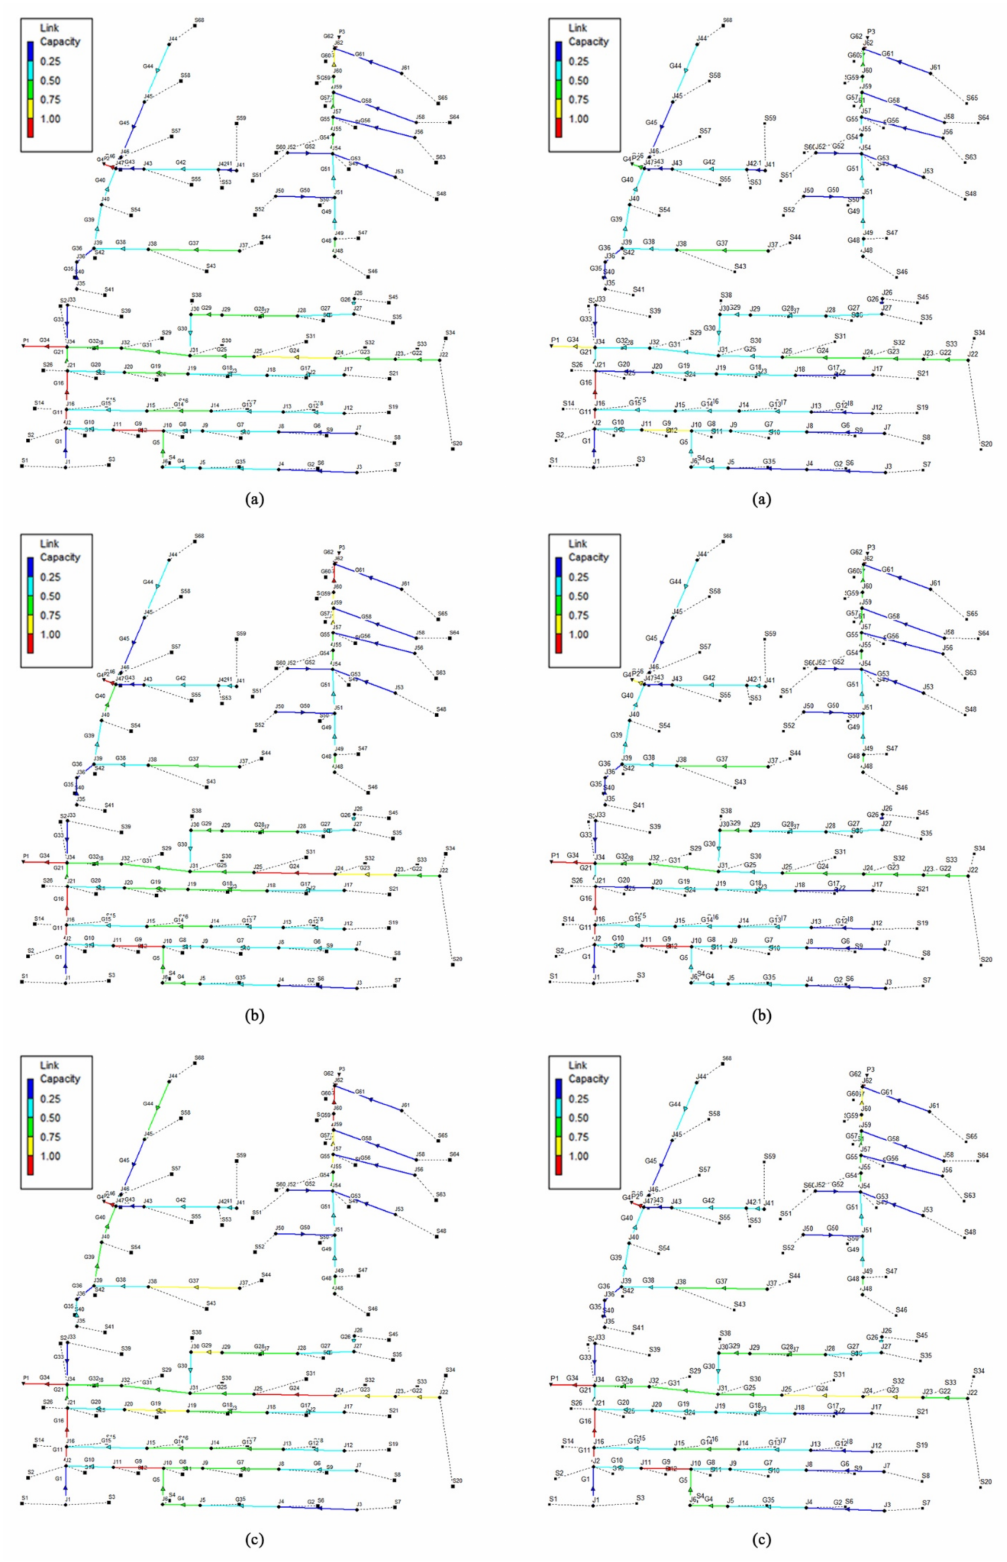
Figure 8. Flood simulation of each link for Scenario 1 (left) and 2 (right) under storm conditions with 5-, 10-, and 20-year recurrence intervals: ( a ) 5-year; ( b ) 10-year; ( c ) 20-year. Different colors represent different capacities for floodwater from each link. Red lines indicate the high capacity for floodwater volumes and blue lines indicate the low capacity of for floodwater